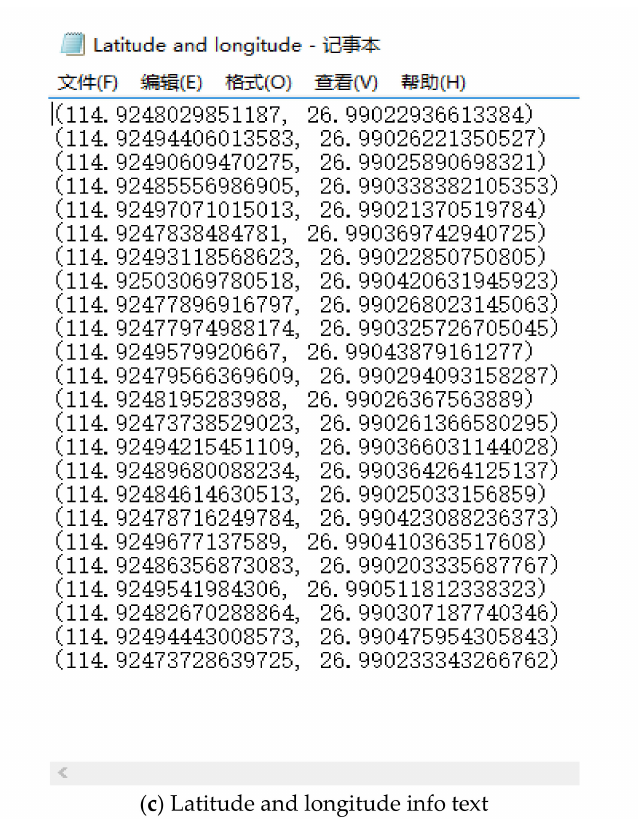
Figure 8. The detection e ff ect of the final model, the output result of geographic information and the generated geographic information